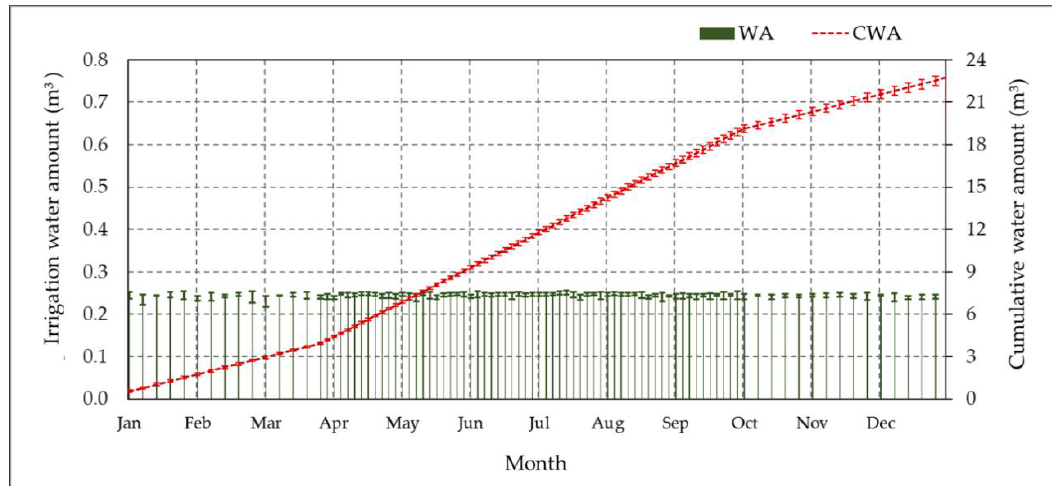
Figure 15. The mean applied water amount (WA) and the mean cumulative supplied water amount (CWA) in cubic meters over the year 2020 in the experimental site using the designed controlled subsurface irrigation system (CSIS) with the time-based irrigation scheduling method (T-BIS).